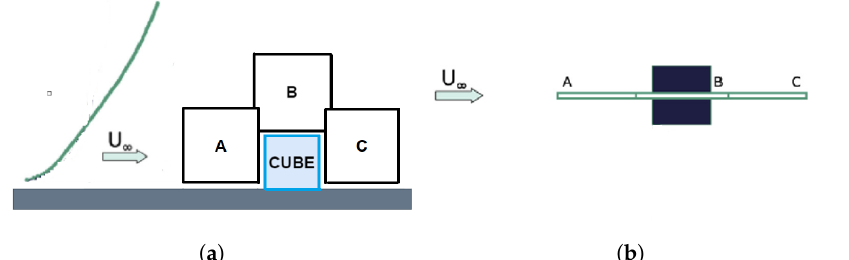
Figure 2. Configuration of the geometry of the PIV experiment and the planes on which PIV measurements were performed [35]: ( a ) side view, ( b ) top view. Adapted with permission from Ref. [35]. 2022